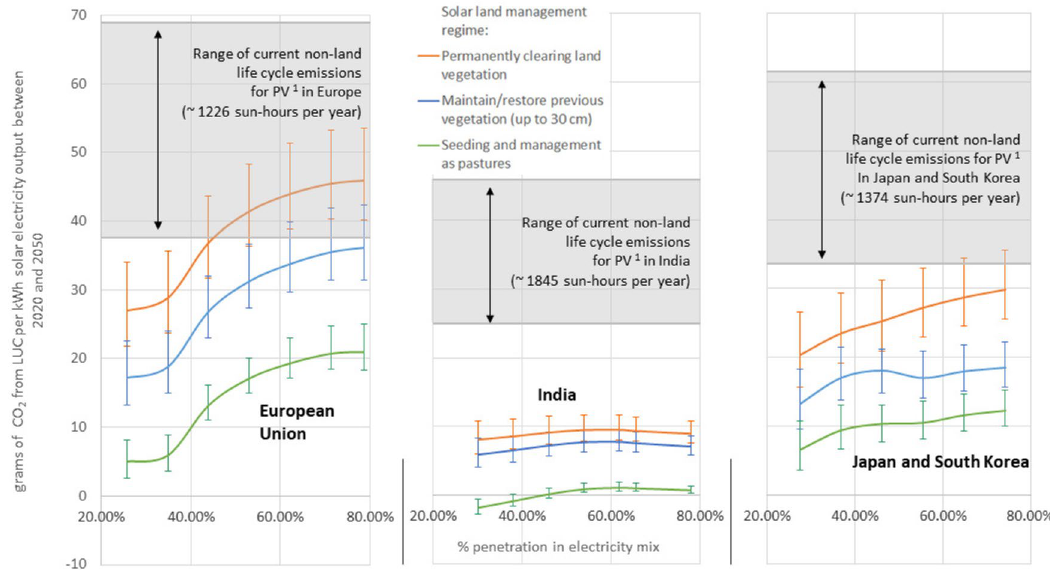
Figure 3. Land use change emissions related to land occupation per kWh of solar energy from 2020 to 2050, for the three solarland management regimes applied (see “Methods” section for more details), and relative to other life cycle emissions of PV systems (depend on location of installation) and emissions from natural gas fired electricity (independent of location). Uncertainty bounds reflect solar module efficiency scenarios (reaching average efficiencies of 20, 24 and 28% for modules installed in 2050; see Section 2c in SM). 1 Non-land life cycle emissions of PV are based on a range of PV technologies, including mono and multicrystalline silicon (higher range), thin-film CdTe (lower range), CIS and a-Si systems as calculated in Liu & van den Bergh (2020) 42 , and based on an average global carbon intensity of electricity (0.48 kg CO 2 /kWh). The range is calculated by dividing the regionally weighted solar electricity output per m 2 as used in this study, by CO 2 emissions per m 2 panel